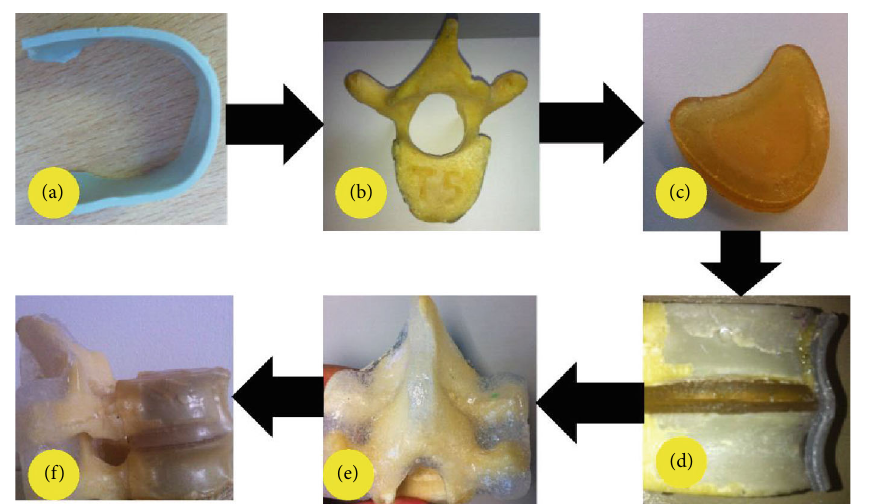
Figure 2: The process fl ow to manufacture paediatric synthetic spine. (a) Cortical, (b) completed vertebra, (c) disc, (d) assembled ALL and PLL, (e) added posterior ligaments, and (f) completed